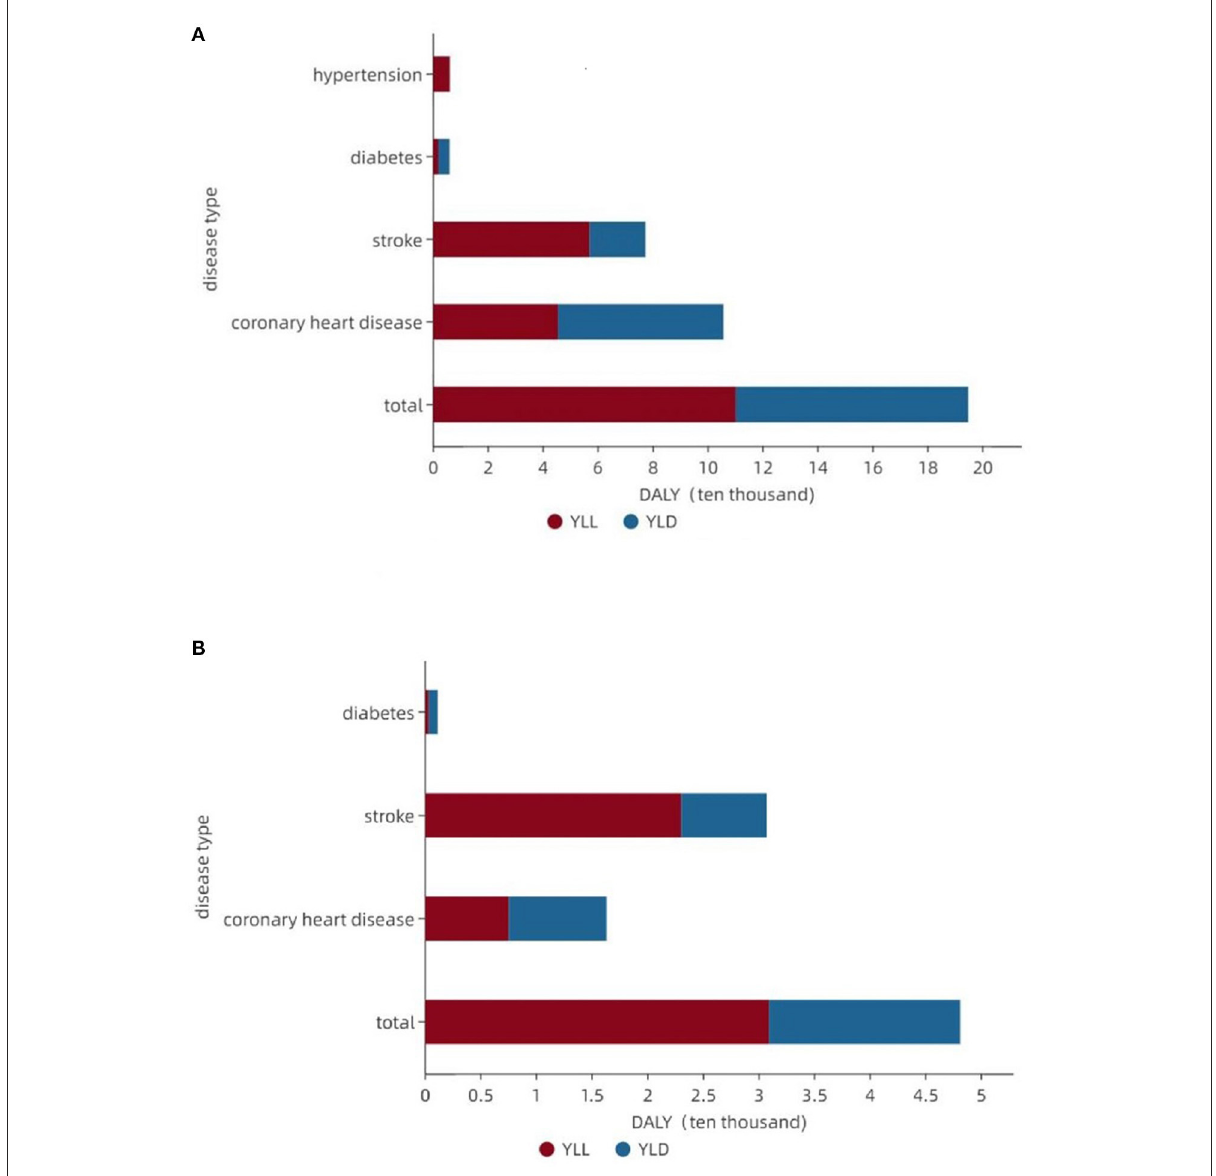
FIGURE3 Composition of the disease burden attributable to smoking and drinking for major chronic diseases. (A) Major chronic disease burden attributable to smoking. (B) Major chronic disease burden attributable to